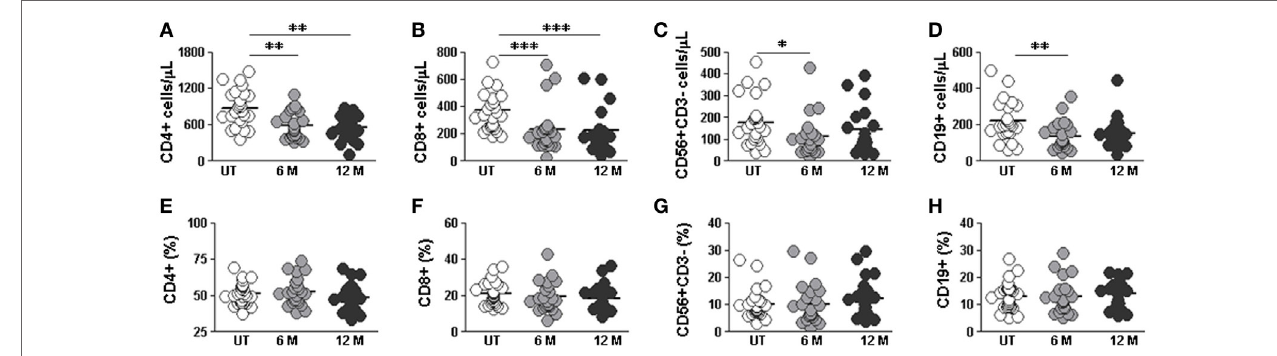
FigUre 3 | Effect of dimethyl fumarate on CD4, CD8, NK, and B cells from multiple sclerosis (MS) patients. (a–D) Cell counts and (e–h) percentages of peripheral CD3